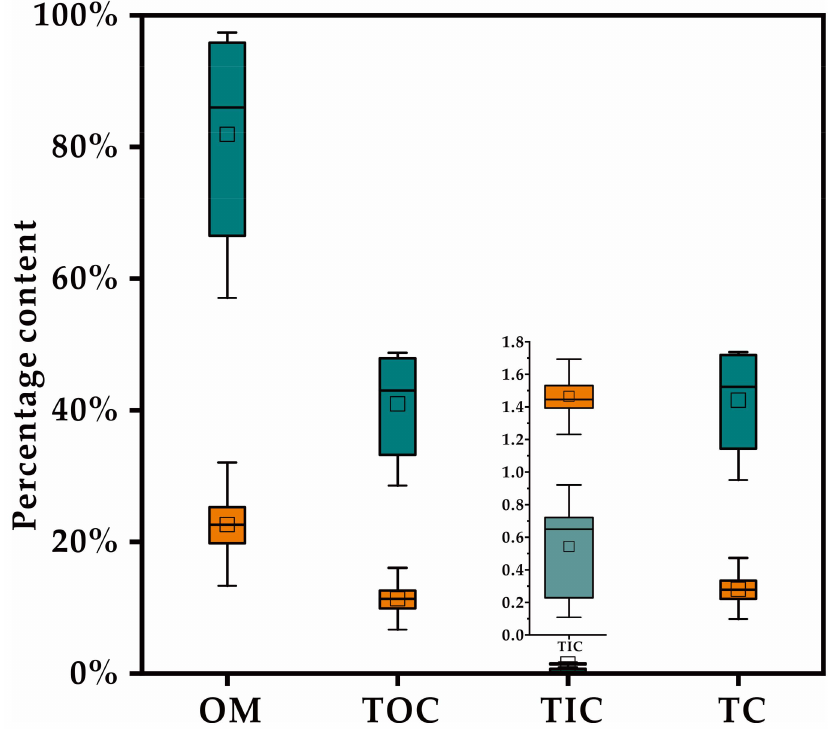
Figure 2. The boxplot of OM and carbon percentage content in soil samples (orange) and plant samples (cyan). The bottom, top and medium band of the box are the 25th, 75th and 50th percentiles. The horizontal line above and below the box are the maximum and minimum value, and the square in the box is the mean